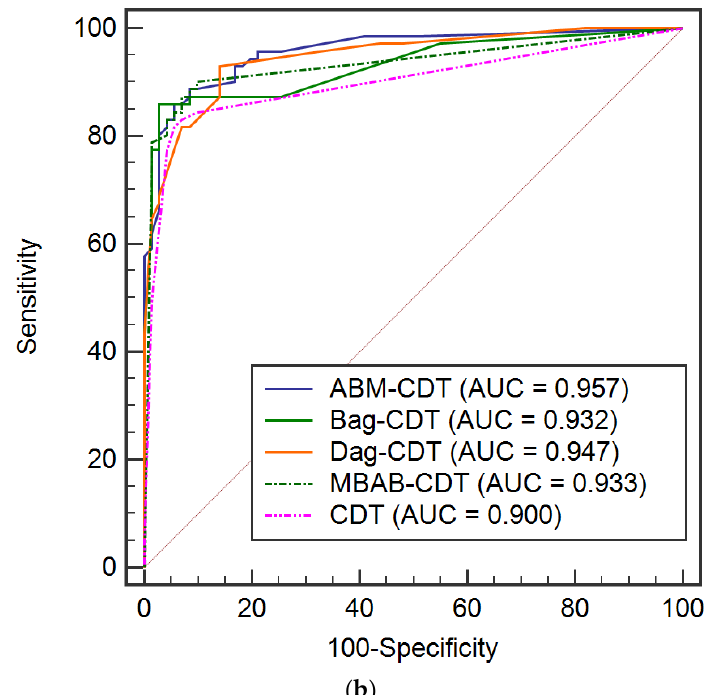
Figure 6. Analysis of Receiver Operating Characteristic (ROC) of the models: ( a ) training dataset and ( b ) validating dataset .